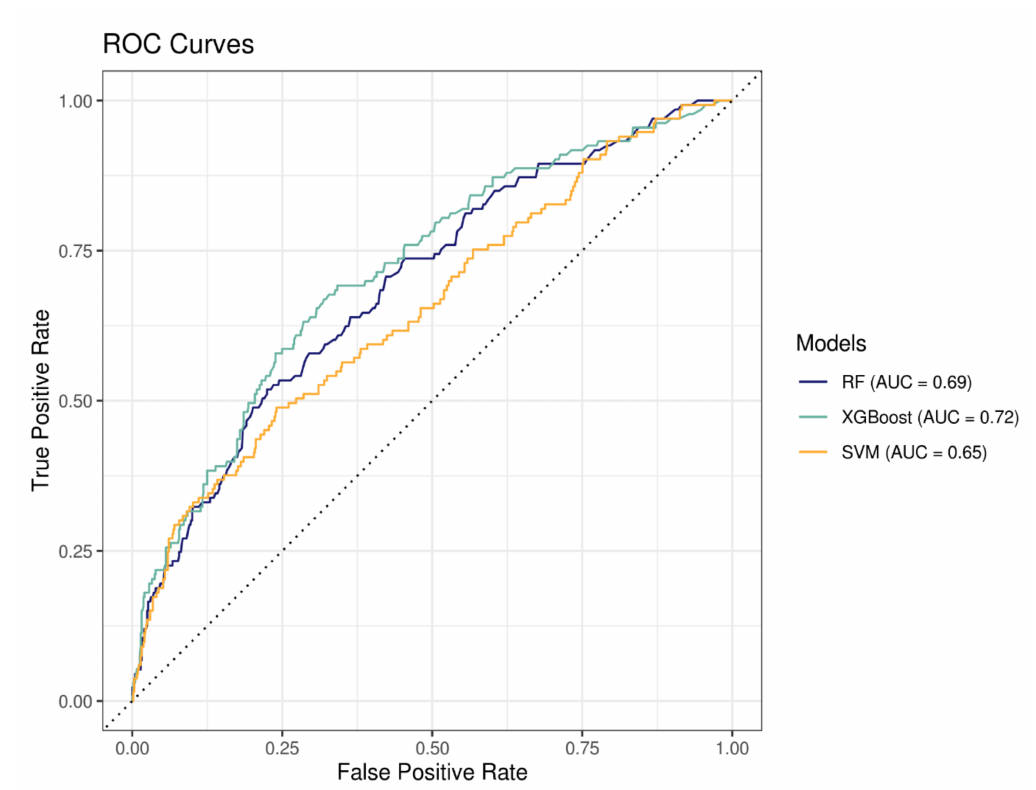
Figure 3. Receiver operating characteristic (ROC) curves representing the sensitivity (true positive rate) as a function of 1-specificity (false positive rate) for all possible thresholds values. RF = random forest, XGBoost = extreme gradient propulsion, SVM = support vector machine and AUC = area under the